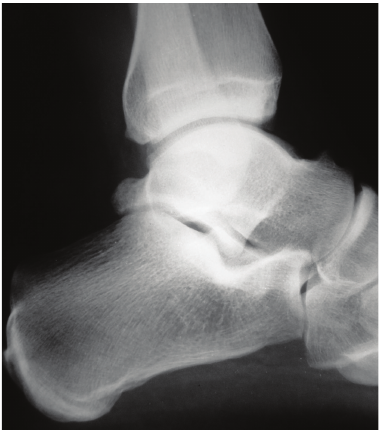
Figure 1: Lateral X-ray. Prominent posterior talar process.